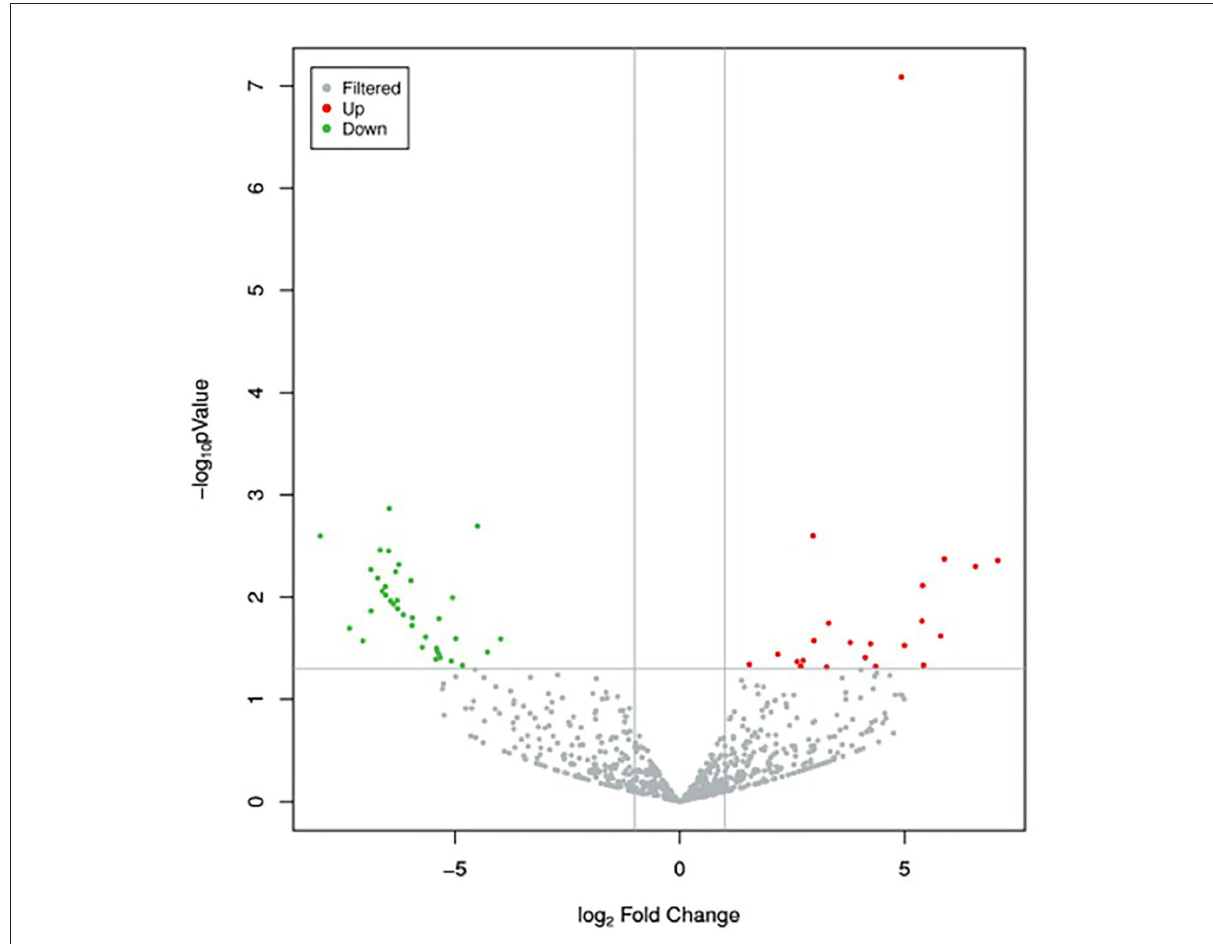
FIGURE2 Volcano plot of differentially expressed miRNAs between the two groups. Red dots and green dots denote miRNAs were up-regulated and down-regulated in the group of donor cows, respectively. The significance cut-off was set to a p -value of 0.05 and |log 2 FoldChange|of